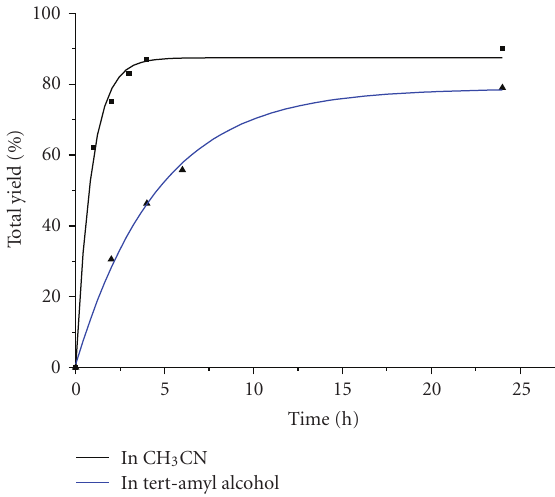
Figure 3: Time-dependent reaction profiles for cyclohexene oxi- dation catalysed by LFe III Cl with H 2 O 2 in CH 3 CN and tert- amylalcohol. either CH 3 CN or tert -amylalcohol. Cyclohexene,